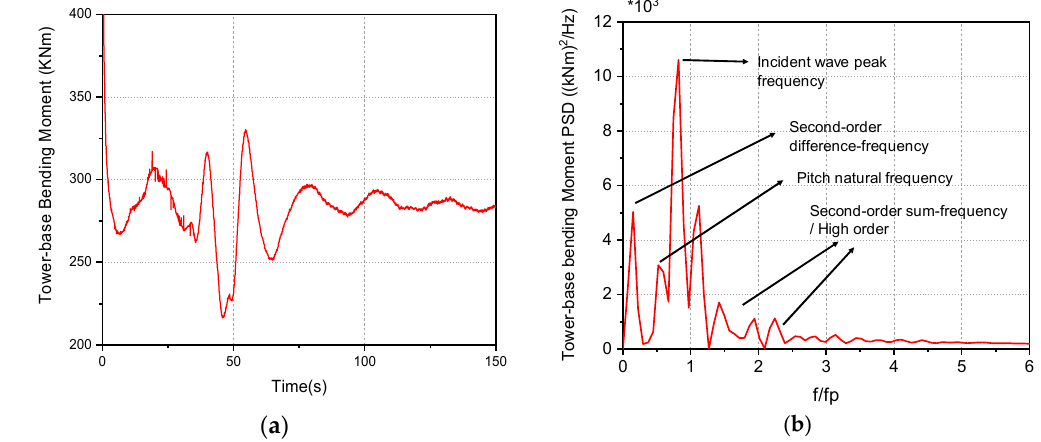
Figure 28. Tower-base bending moment and PSDs analysis for a parked wind turbine subject to focused wave: ( a ) tower bending moment; ( b ) PSDs of tower bending moment.